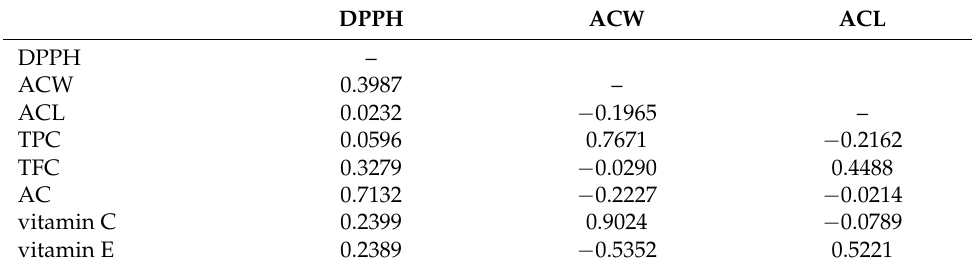
Table 10. Correlation coefficients (R) between different methods: DPPH, ACW, ACL, total phenolic content (TPC), total flavonoid content (TFC), anthocyanin content (AC) and the content of vitamins C and E in the samples of the selected Sorbus